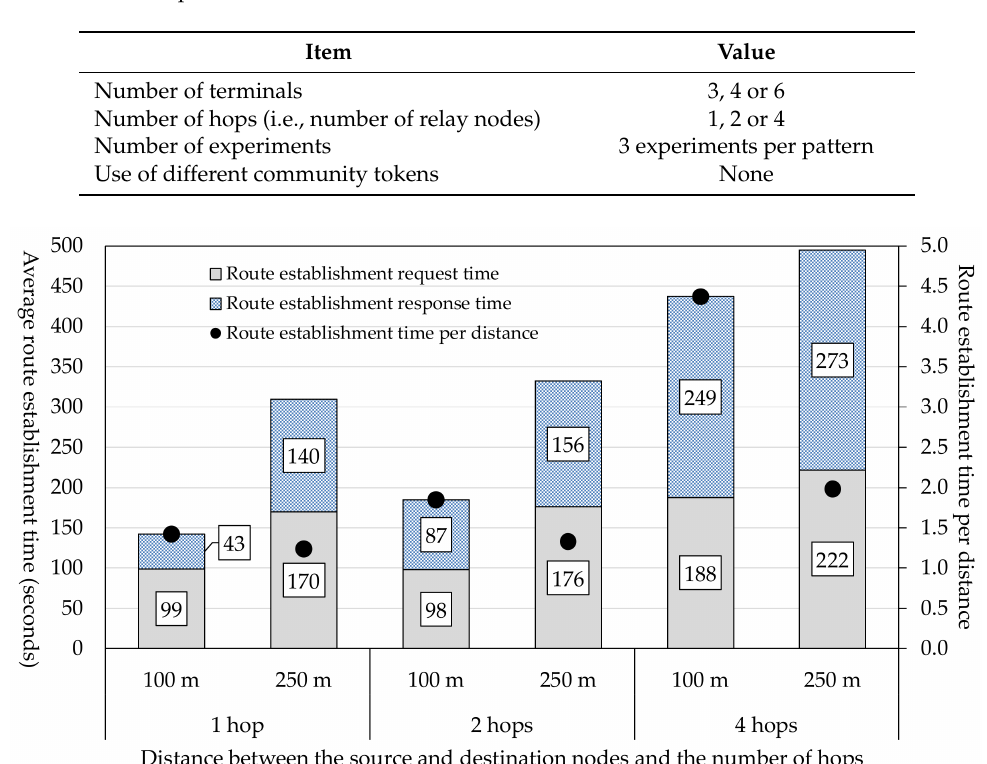
Table 9. Experimental conditions for the measurement of the route establishment time.